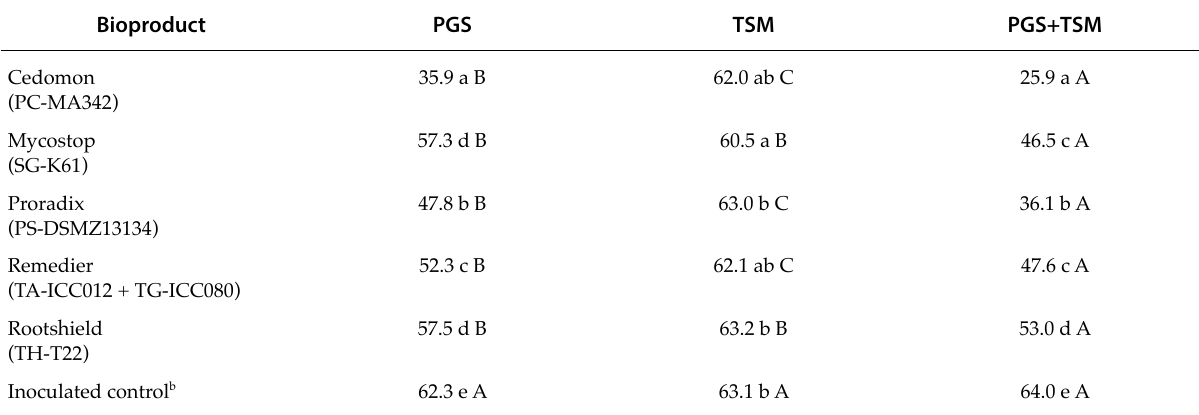
Table 4. Effect of bioproducts applied to plant growth substrate (PGS), to transplantation soil mixture (TSM) and to both (PGS+TSM) on the disease severity a of zucchini caused by Fusarium solani f. sp. cucurbitae strain 7 (FSC7) inoculated in TSM, in greenhouse